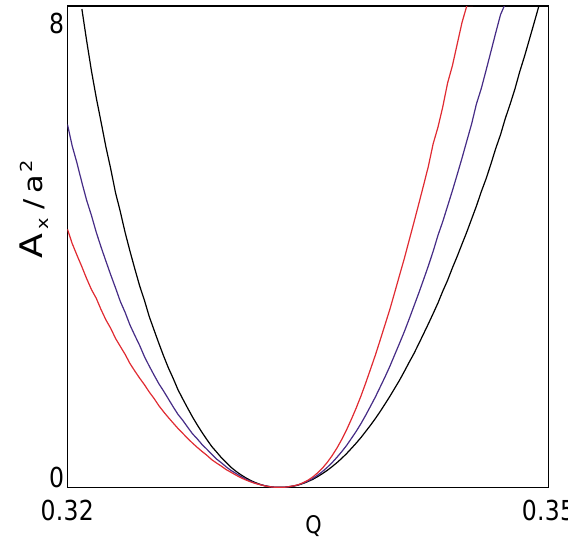
FIG. 9. (Color) Plot of the area of the stable region A x (cid:1) pe x normalized to a 2 , as a function of the linear tune Q (cid:1) v (cid:1) 2 p for a ˆ K 0 2 (cid:1) 0.3 and different values of the space charge intensity. Black line, ˆ j (cid:1) 0 ; blue line, ˆ j (cid:1) 0.05 ; red line, ˆ j (cid:1) 0.1